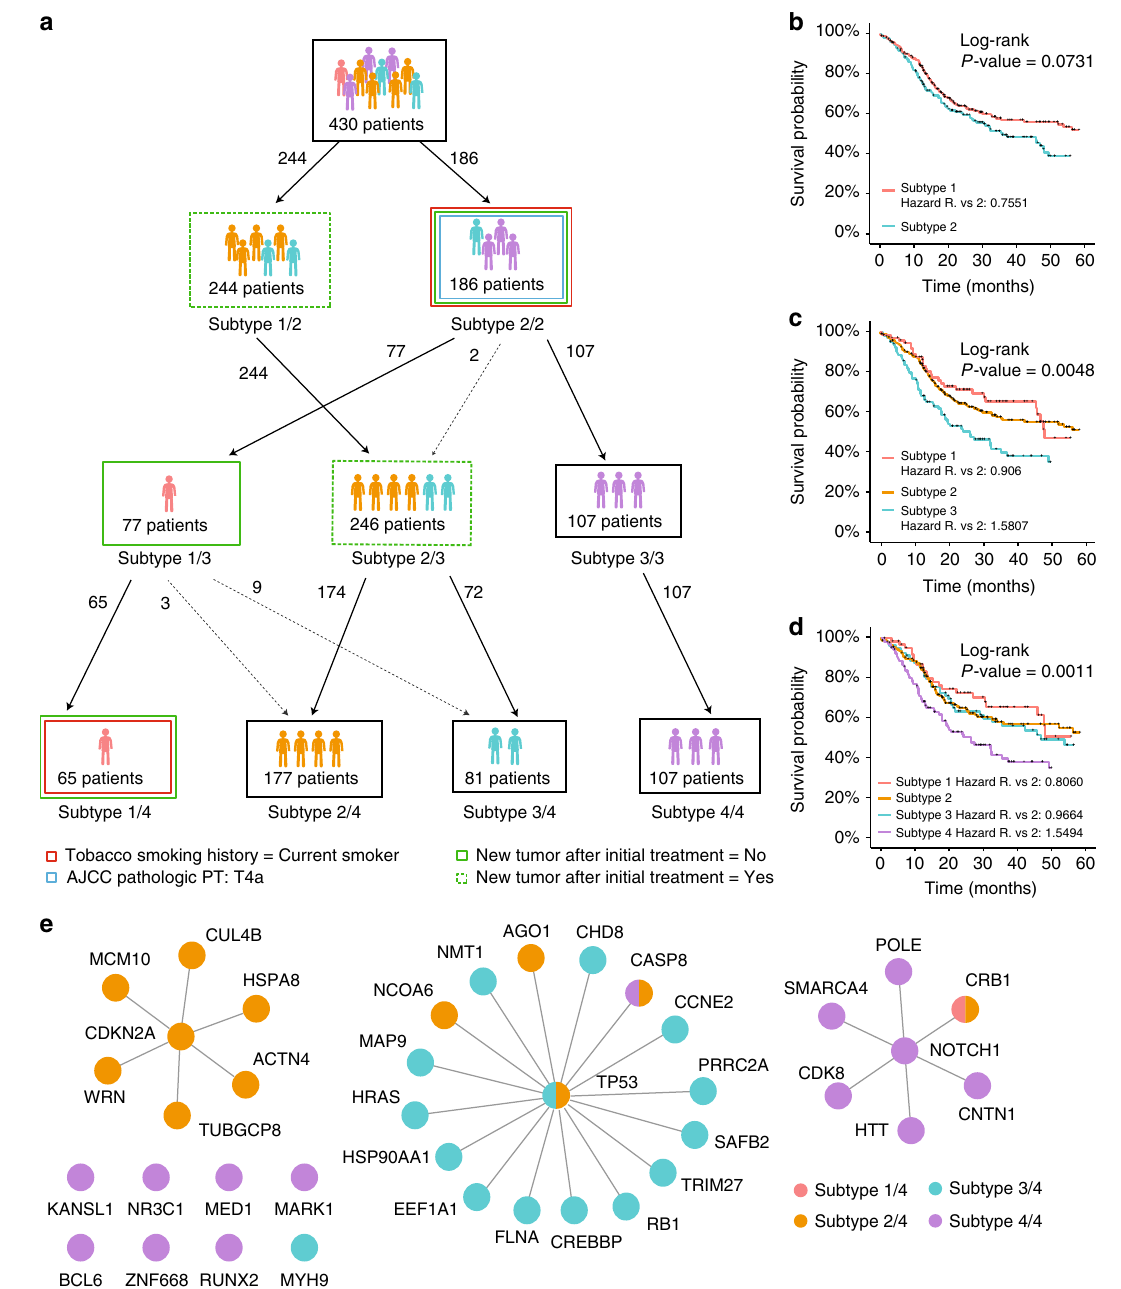
Fig. 4 Hierarchical strati fi cation and characteristic ESPs of head and neck cancer. a Hierarchical organization of tumors at increasing subtype resolution. Layer k of the hierarchy corresponds to clustering cancer patients into k subtypes ( k = 1,2,3,4). b – d Kaplan – Meier survival plots when stratifying tumors into two ( b ), three ( c ), or four ( d ) subtypes. e Mutated ESPs used in assortment of patients into four